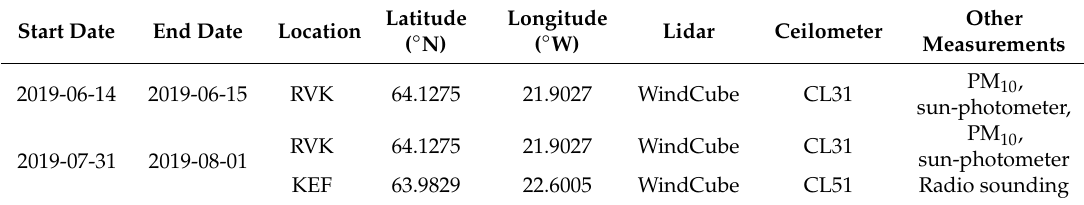
Table 1. The dates, locations and instrumentation available during the two events described in this study.